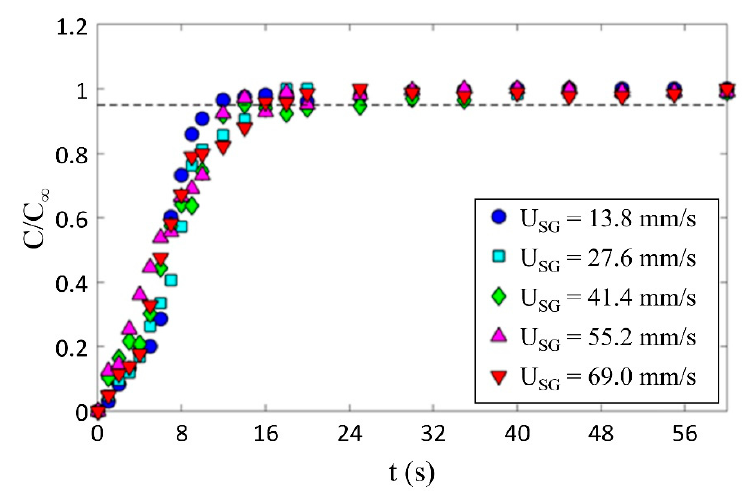
Figure 6. Temporal evolution of the normalized concentration and the effect of gas superficial velocity on mixing time in a bubble swarm.